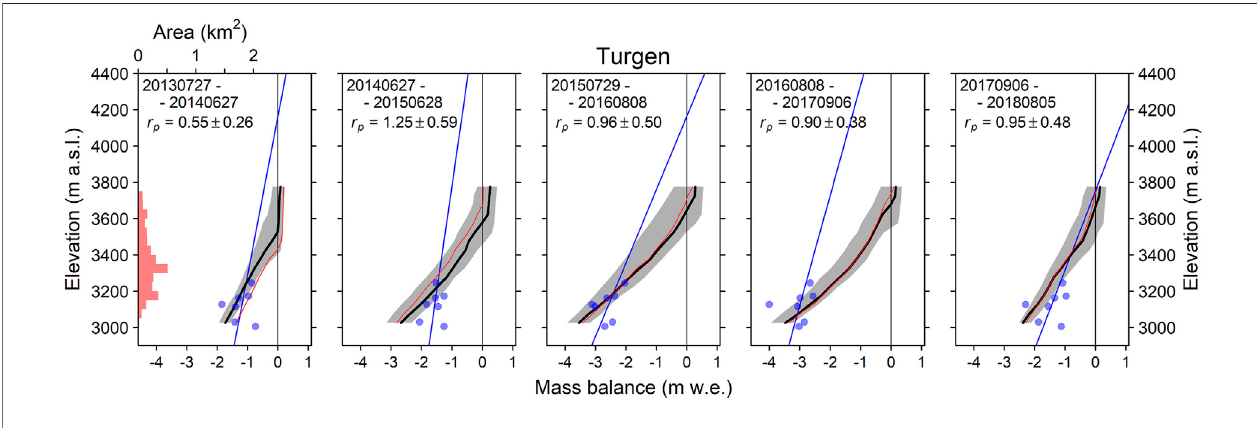
FIGURE 6 | As Figure 3 , but for Turgen Glacier.